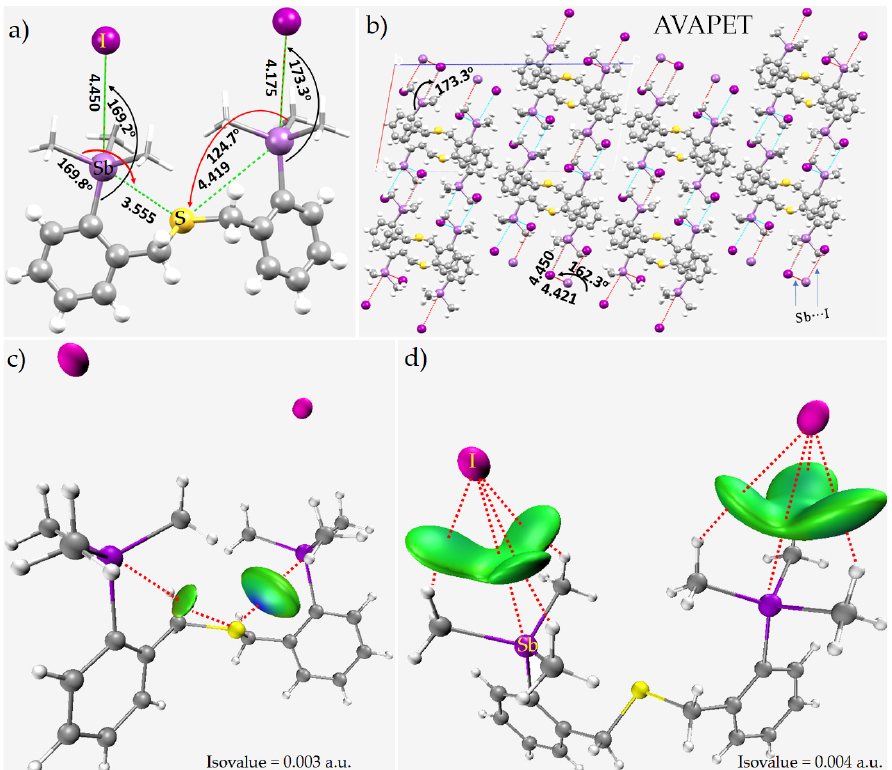
Figure 23. ( a ) Charge-assisted C–Sb···I pnictogen bonding in [S(CH 2 -2-C 6 H 4 SbMe 3 ) 2 ]I 2 . ( b ) The 2 × 2 × 2 unit-cell structure of the crystal, showing the C–Sb···I pnictogen bond networks in the crystal. ( c ) and ( d ) Illustration of the IGM- δ g based isosurface topologies of the C–Sb···S and C–Sb···I pnictogen bonds in ( a ). The detailed nature of pnictogen bonding around the Sb cation may be inferred from Figure 22e (see above). Selected bond distances and angles in Å and degrees, respectively. Atom type and CSD ref. codes in capital letters are shown. Atoms are shown as small spheres and bonds as lines in atom color, whereas the intermolecular interactions are represented by dotted lines.